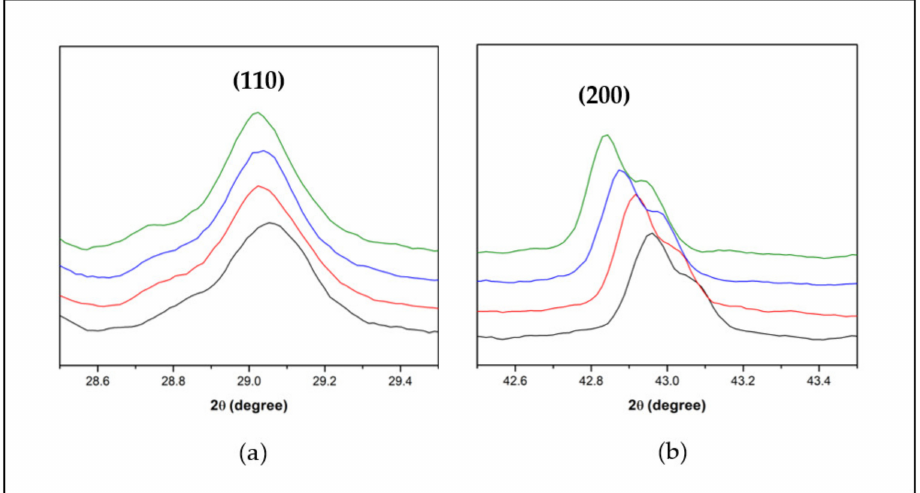
Figure 2. Enlargement of: ( a ) BCZY peak at (110); and ( b ) NiO peak at (200) showed that the peaks shift to the left side due to the lattice expansion. Table 1. The Lattice parameter of NiO and BCZY at temperatures of 400 to 700 ◦ C. Temp. ( ◦